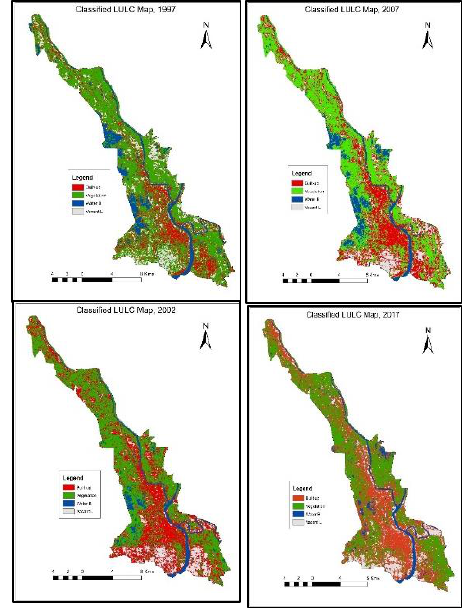
Figure 5. LULC Change